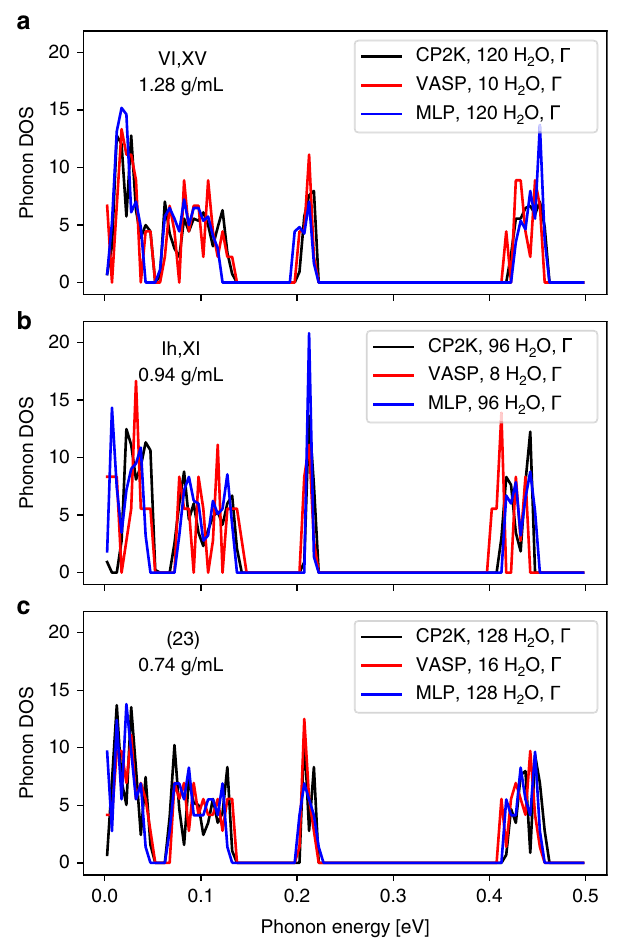
Fig. 3 A comparison between the phonon density of states (DOS) for three ice structures. a – c Results for three indicated ice phases with distinct densities. The three sets of DOS in each panel were computed using revPBE0-D3 DFT calculations employing VASP , revPBE0-D3 DFT calculations employing CP 2 K , and the MLP, all at the Gamma ( Γ ) point. The densities predicted at the MLP level are indicated. Source data are provided as a Source Data fi